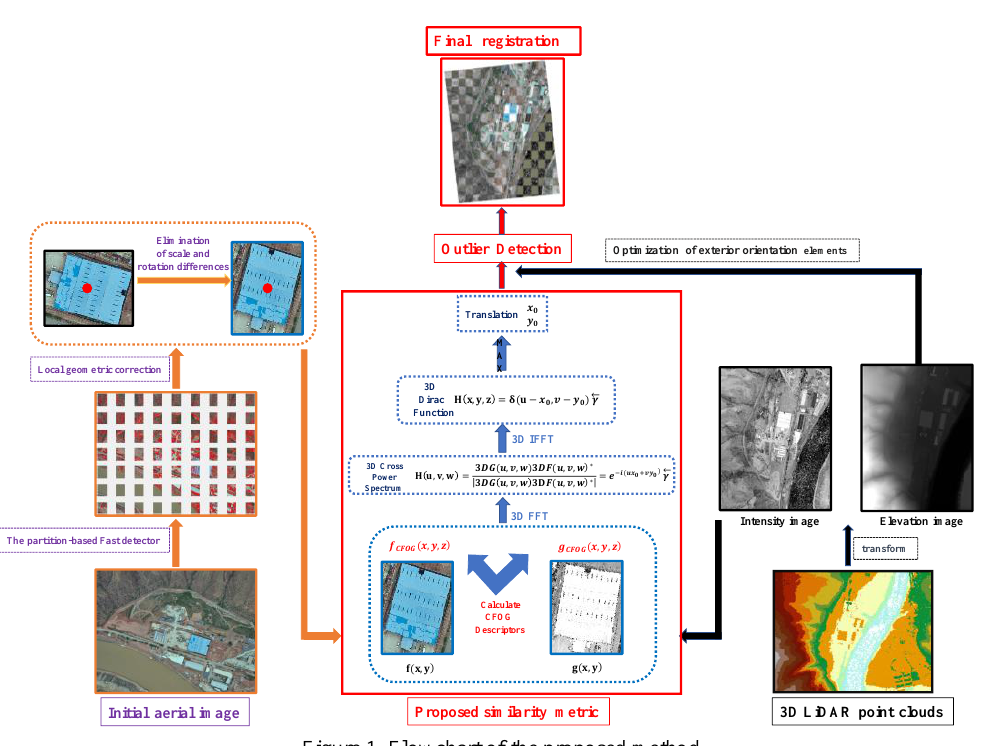
Figure 1. Flowchart of the proposed